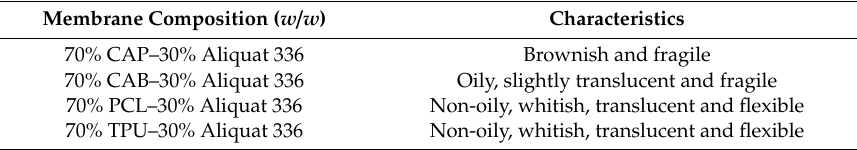
Table 1. Characteristics of the PIMs prepared with thermo-compression procedure.